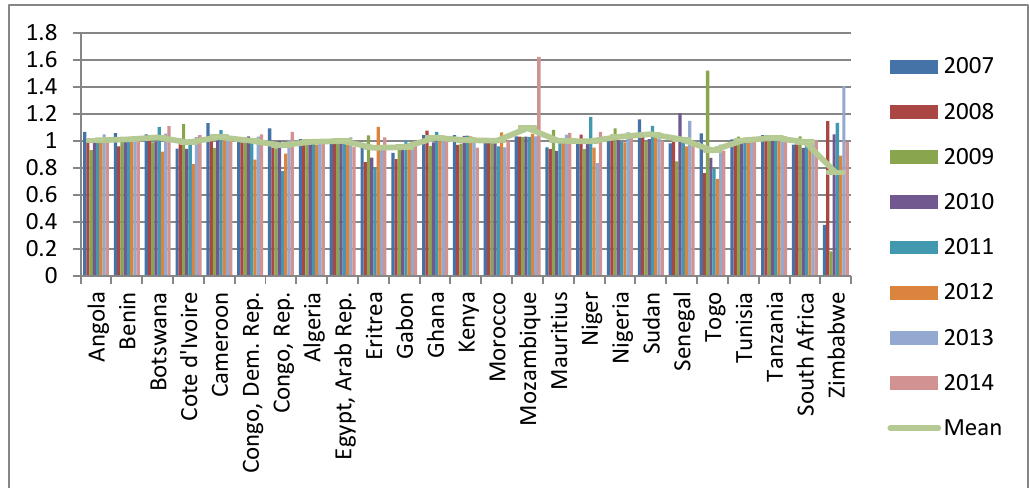
Figure 4. The energy productivity estimates with CO 2 emission in Africa during 2006–2014.